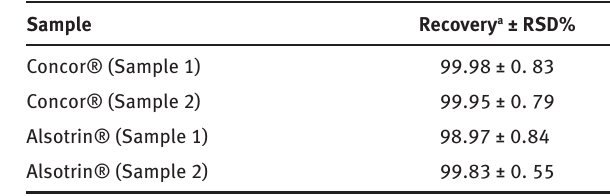
Table 7: Estimation of BIS and ALV in human serum by applying